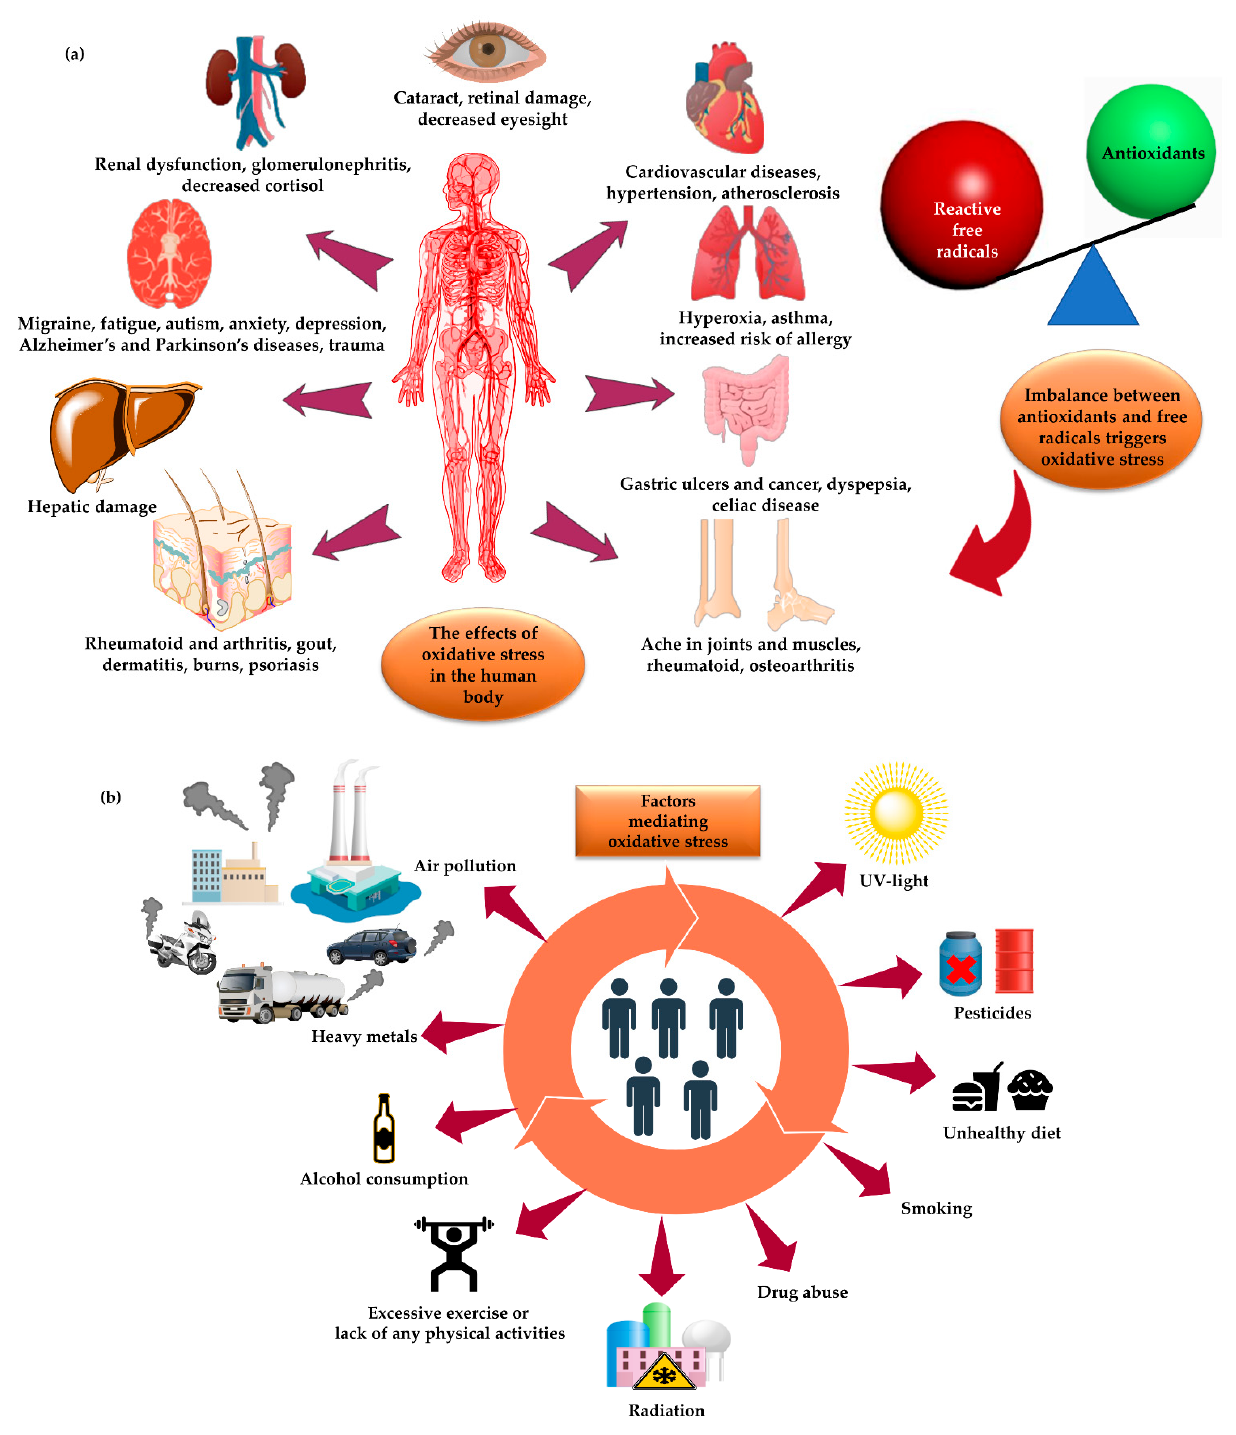
Figure 1. Exposure to different toxic chemicals triggers oxidative stress progression ( a ) and the incidence of oxidative stress in the human body is accompanied by a plethora of pathological diseases and disorders that cause damage to the heart, lungs, intestine, joints, muscles, skin, liver, brain, kidneys, eyes, and immune system ( b ). The reaction of antioxidants with free radicals is governed by various mechanisms, involving hydrogen atom transfer (HAT), single electron transfer (SET), and proton-coupled electron transfer mechanisms [13,14]. The HAT mechanism is based on the ability of antioxidants to quench free radicals by detaching a phenolic hydrogen atom from the antioxidant via homolytic cleavage of the O–H bond to the free radical, producing a stable product [15]. In this mechanism, the antioxidant is converted into a radical, which is sig- nificantly more stable than the original free radical, and as a result, inhibiting the overall oxidation processes [16]. The bond dissociation enthalpy (BDE), a numerical parameter